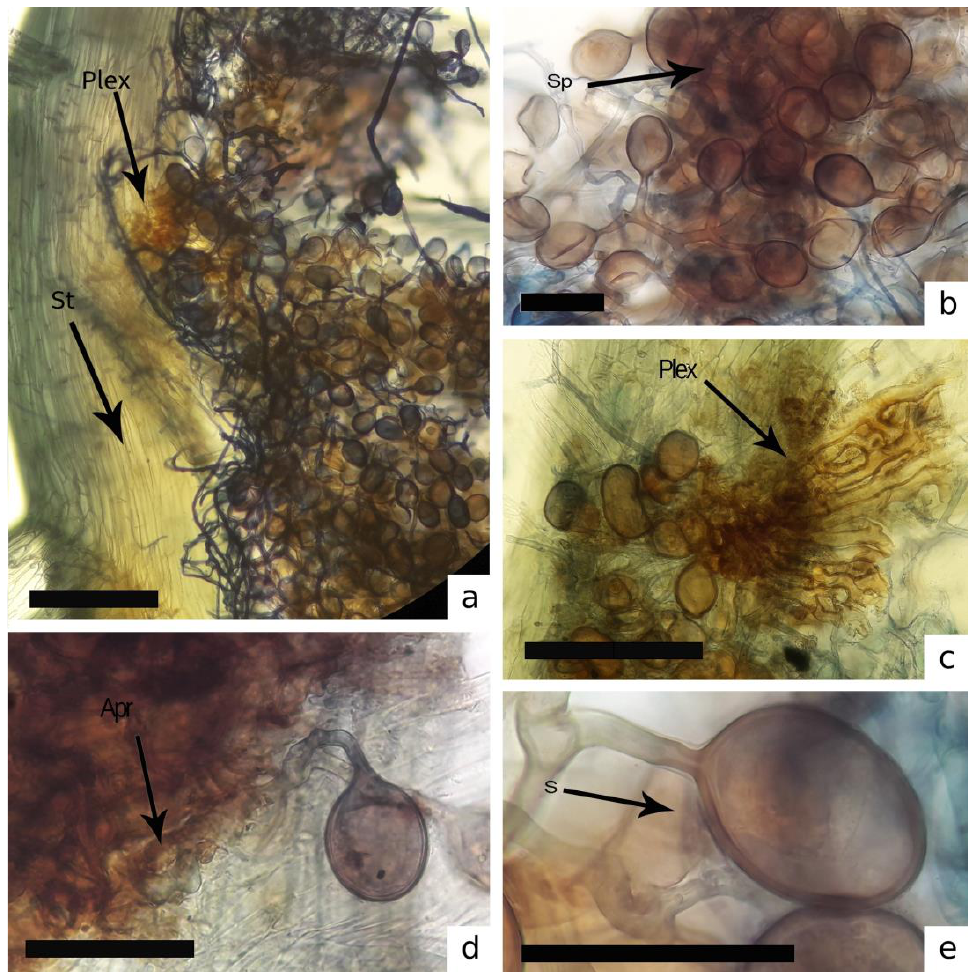
Figure 3. Structures of Dominikia aurea associated with Isopterygium tenerum . ( a – c ) Sporocarps (Sp) with hyphal plexus (Plex) into the stem (St) in the rhizoid region (Apr). ( d , e ) spore (s). [Bars = 50 µm]. Table 1. Presence (x)/absence (-) of arbuscular mycorrhizal fungi structures and dark septate endo- phytes in bryophyte thallus. Inter- (InterHy) and intracellular hyphae (IntraHy); coils (hc); vesicles (ves); spores (s); Sporocarps (Sp) and dark septate endophytes